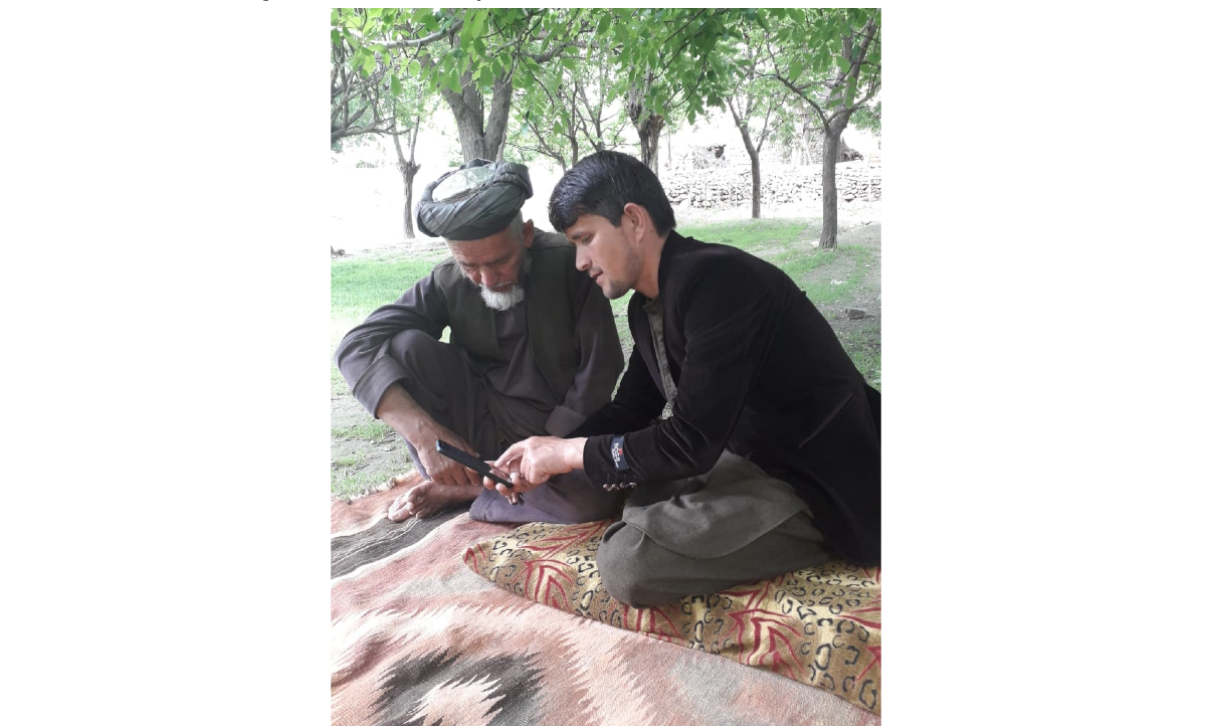
Figure 3. Awareness content being shown to the